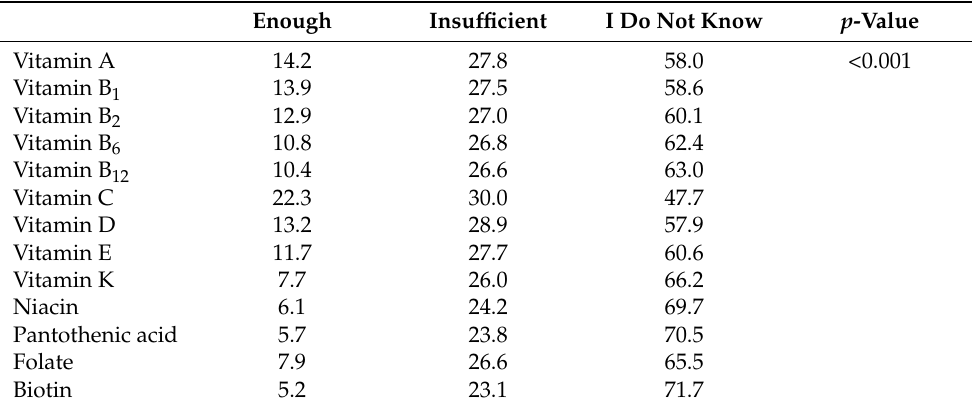
Table 7. The perception of one’s vitamin intake